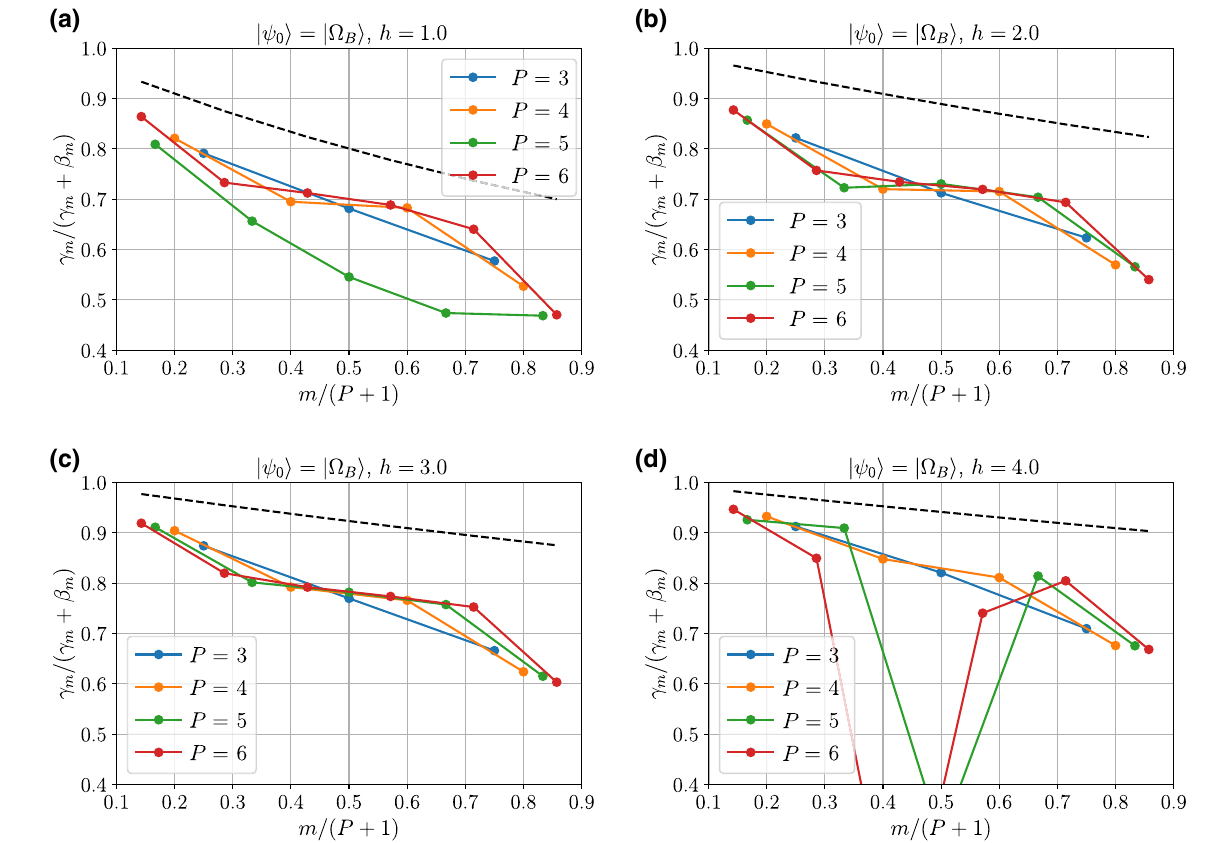
FIG. 16. Variational parameters associated with the best result out of ten local minimum searches, following the two-step optimiza- tion procedure. In each panel, the black dashed line corresponds, through Eq. (B5), to the linear annealing schedule defined by Eq. (17), with the corresponding value of h and P = 6 steps. The quantum circuit is initially prepared in the magnetic ground state | (cid:5) B (cid:3)